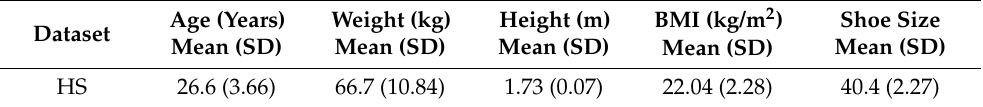
Table 1. Demographic data of the